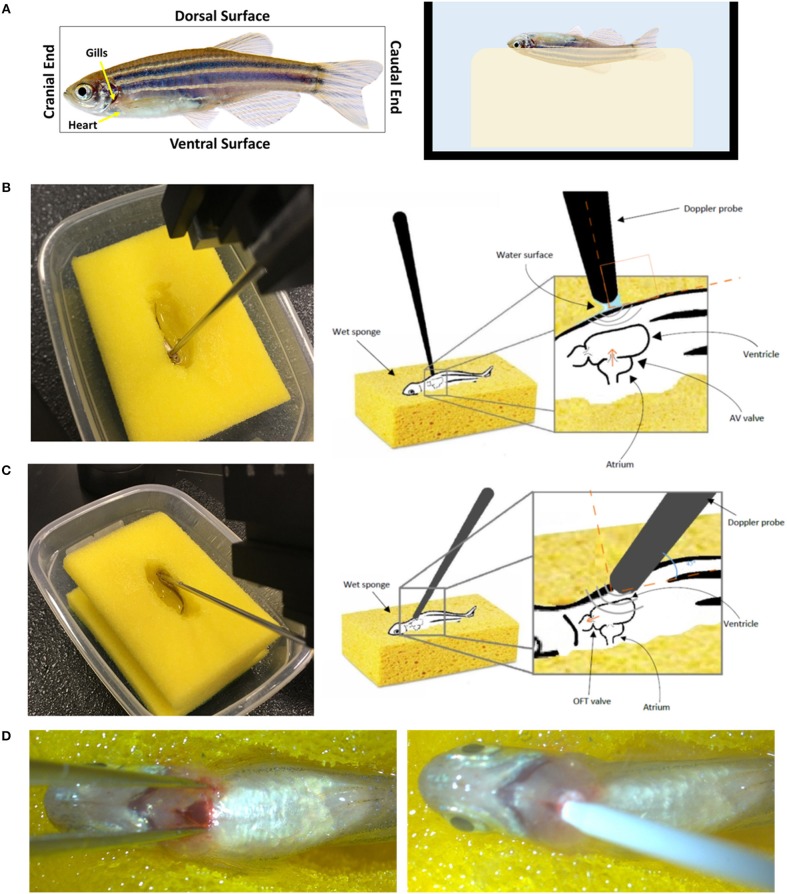
Setup and orientation of zebrafish for Doppler echocardiography analysis. (A) The fish is stabilized on a wet sponge on its dorsal side toward the sponge making sure it is fully immersed in water. The 20 MHz transducer probe is positioned (B) perpendicular to the ventral side of the fish to obtain the atrioventricular valve (AV) flow or (C) at an angle to obtain the outflow rack (OFT) flow. (D) Myocardial infarction induction using cryoinjury. The fish in (A) was obtained from www.shutterstock.com.